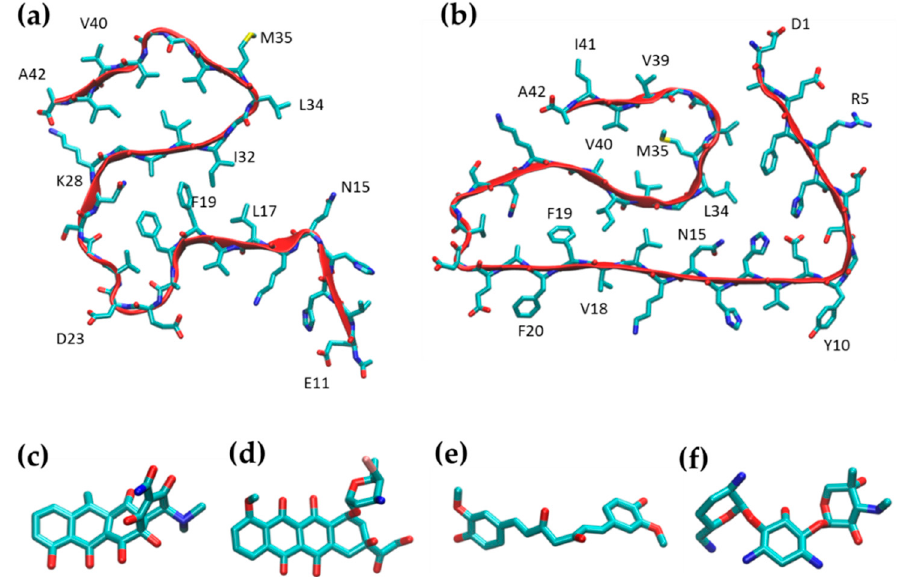
Figure 2. Molecular models of the amyloid A β 42 fibrils and the small molecules tested. For the simulations, we considered two different polymorphs of A β 42 fibril structures, with five peptides of the 2MXU PDB entry ( a ) and five peptides of the 5OQV PDB entry ( b ). Structures of candidate anti-amyloidogenic molecules: doxycycline ( c ), IDOX ( d ), curcumin ( e ) and gentamicin (negative control, f ).